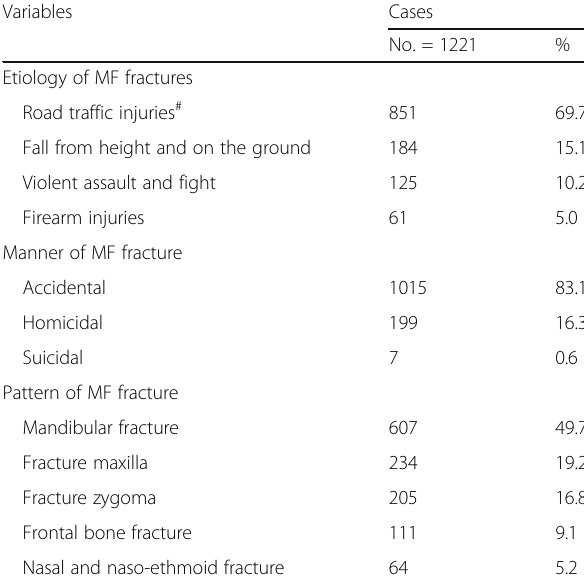
Table 1 Medico-legal aspects of craniomaxillofacial fracture cases in the studied period (2011 – 2016)